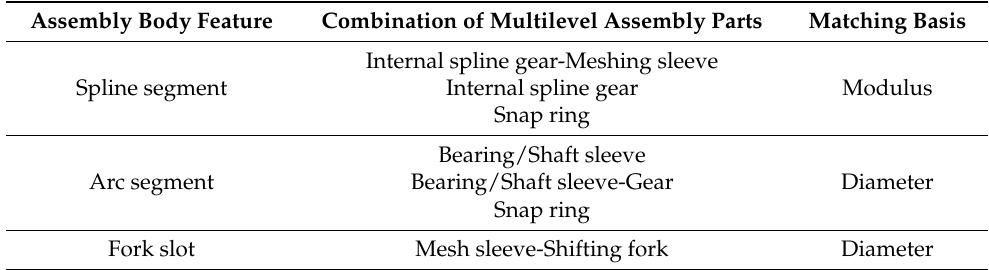
Table 6. Part feature matching knowledge framework.